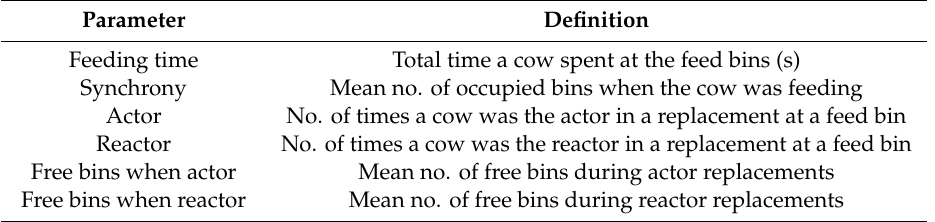
Table 1. Definitions of the behaviors recorded. All measures were recorded daily for each